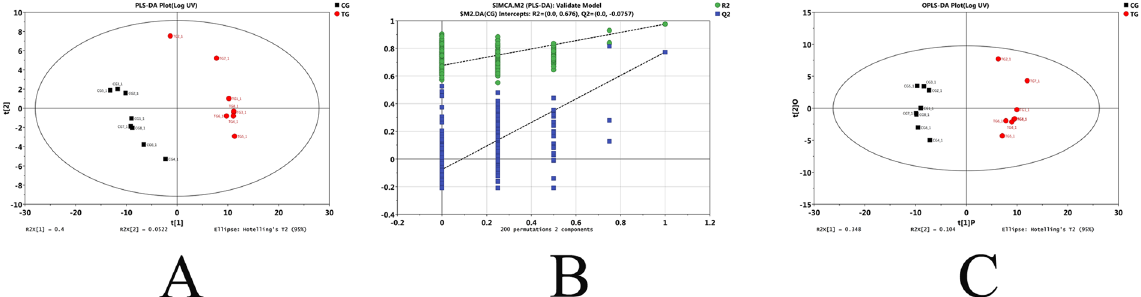
Figure 5. PCA score plots of PLS-DA ( A ), validation plots of PLS-DA ( B ) and PCA score plot PLS-DA Plot ( C ) derived from the GC-TOF/MS metabolite profiles of YC-WM1 in the culture with (TG) and without nicosulfuron (CG).